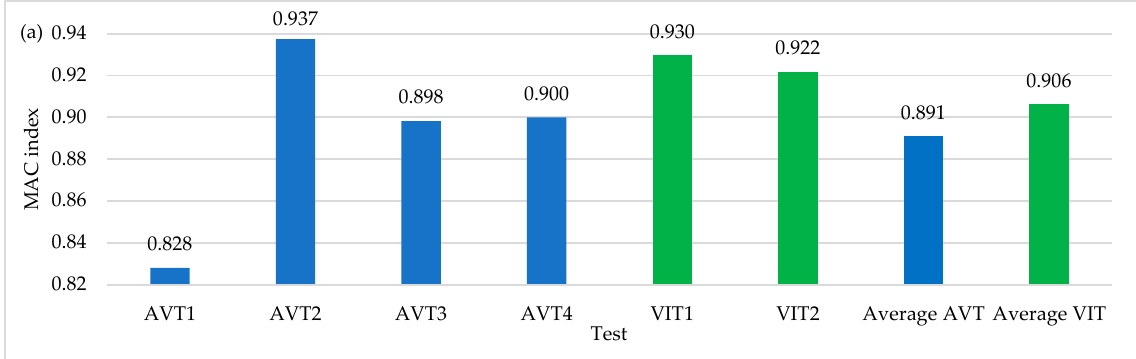
Figure 19. ( a ) Average values of MAC index ( b ) Percentage of relative MAC index error of AVTs with reduced time-series length.